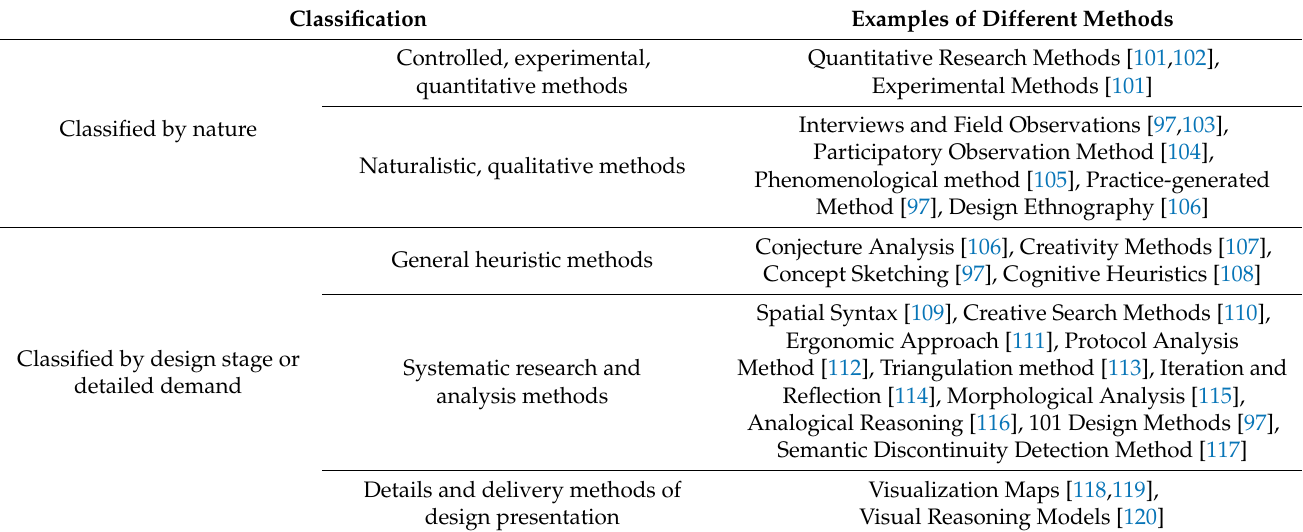
Table 1. Examples of unitary specific Design